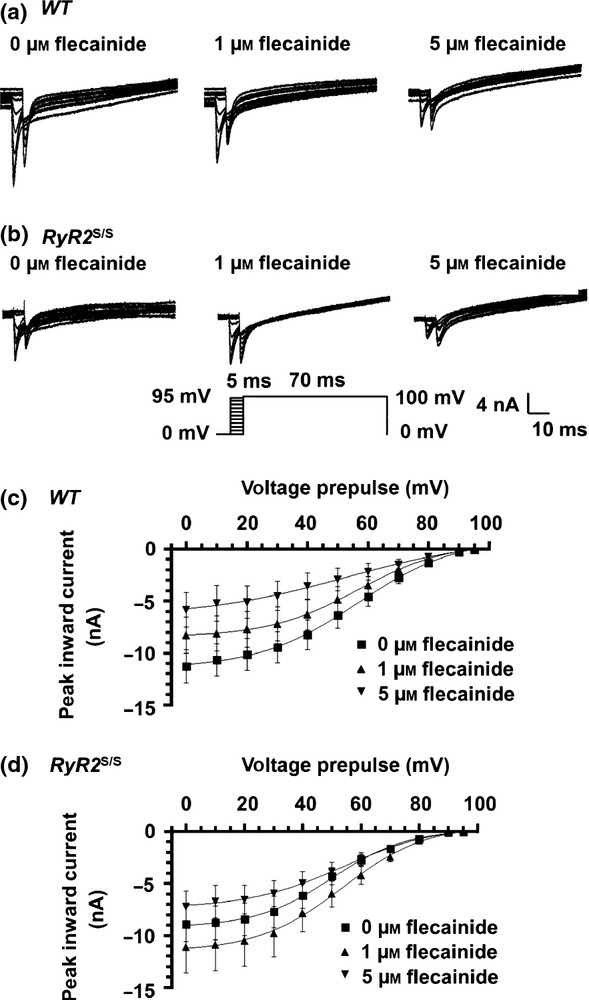
Paradoxical actions of flecainide on INa inactivation in RyR2S/S and WT. Currents in response to successively incremented pre-pulse voltages from 0 to 90 mV, and finally 95 mV, followed by a test voltage excursion of 100 mV in voltage-clamped WT (a, n = 7) and RyR2S/S (b, n = 6) left atria. (c, d) The dependence of peak INa upon pre-pulse voltage excursion fitted to Boltzmann functions for WT (c) and RyR2S/S (d) in the presence of 0, 1 and 5 μm flecainide. These experiments employed the same atria as in the experiments depicted in Figure3.